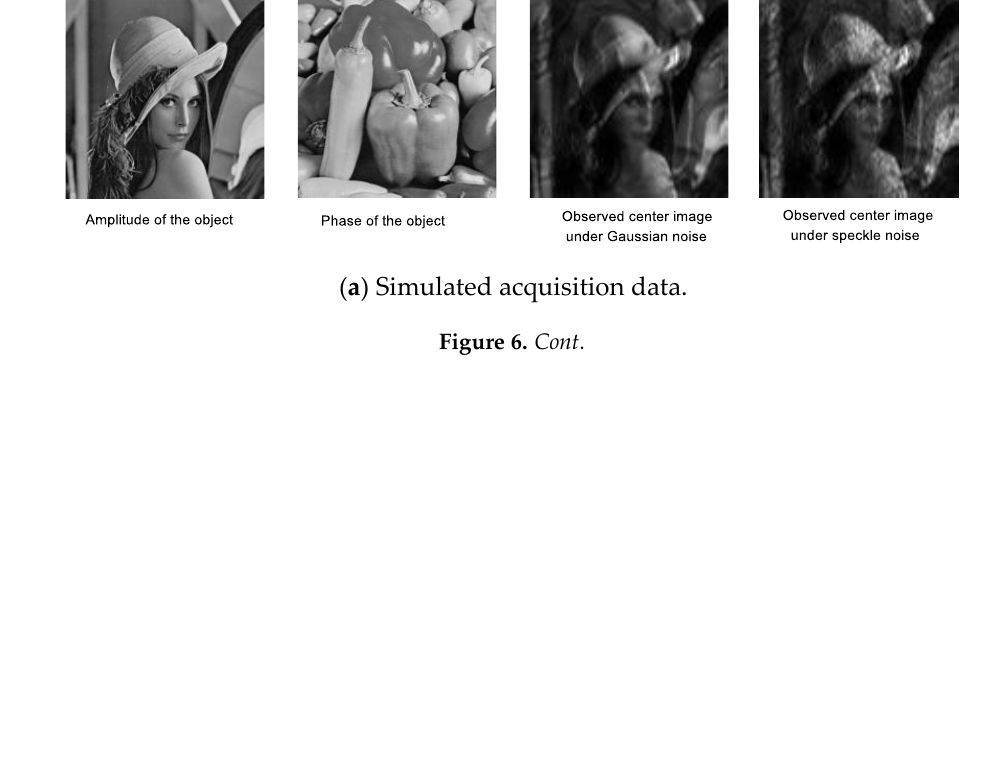
Figure 5. Quantitative comparison of the reconstruction results by different methods under Gaussian noise and speckle noise. Table 3. Comparison of running time between different algorithms.